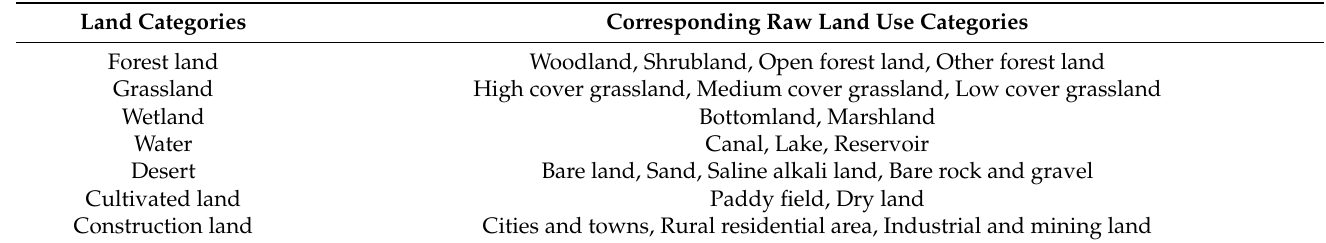
Table 1. Equivalent land use categories between raw data and Xie’s method.